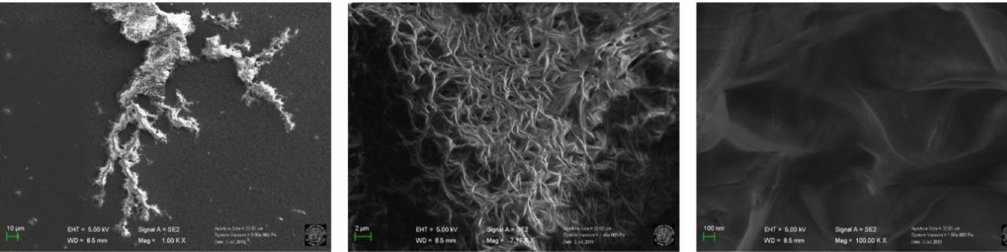
Figure 2. SEM images at increasing magnifications of